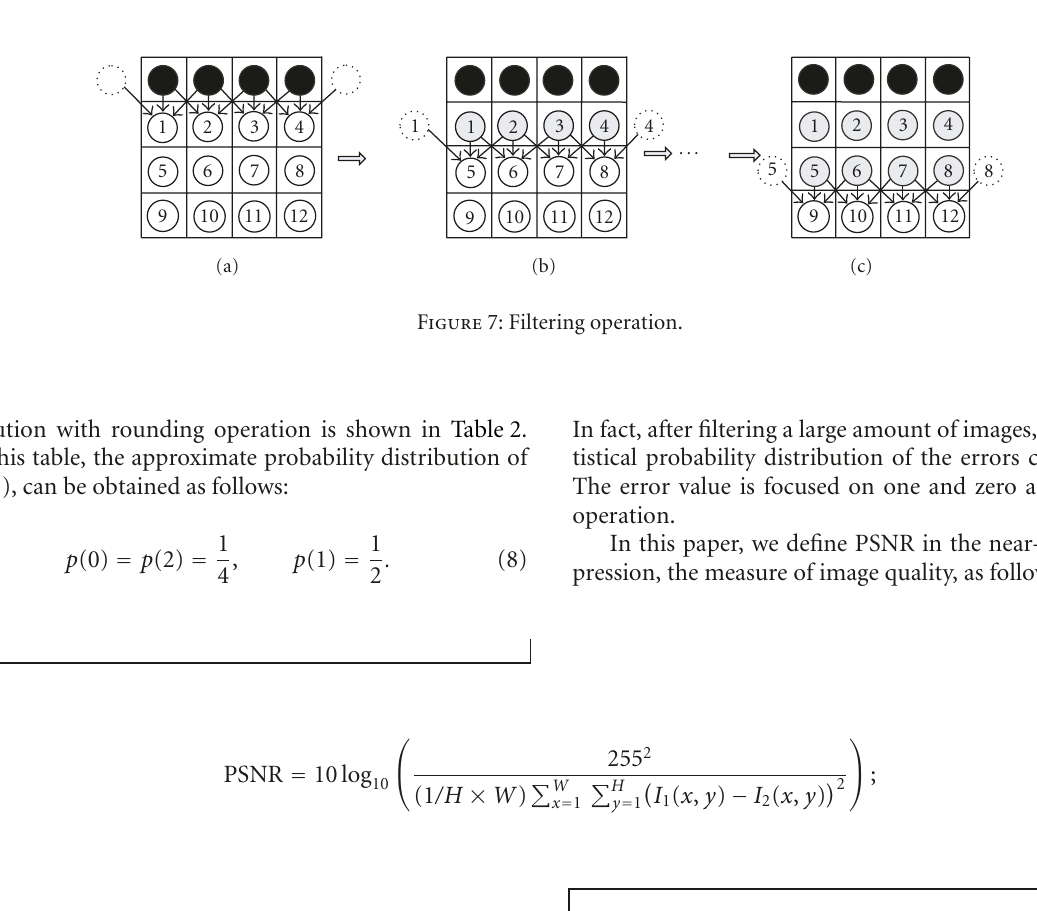
Figure 6: Image transformation operation.